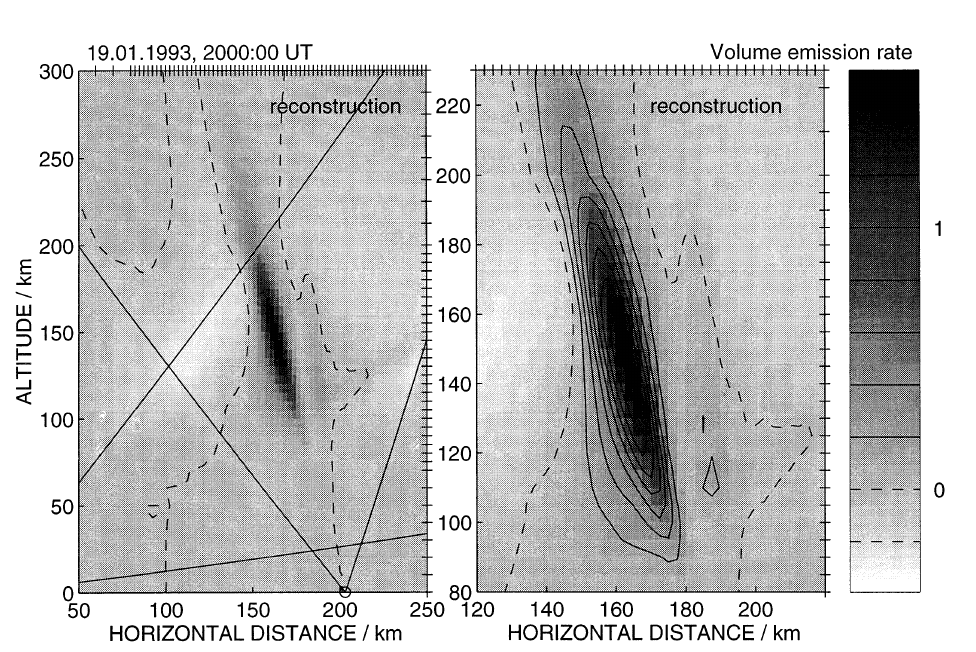
Fig. 9. Volume emission rate reconstructed from the data in Fig. 8 at 1959:40 UT. The sites are shown as dots on the horizontal axis of the left - hand panel with Esrange at 0 km and Troms (cid:249) at 203 km. The viewing angles are shown by the straight lines . The units are arbitrary